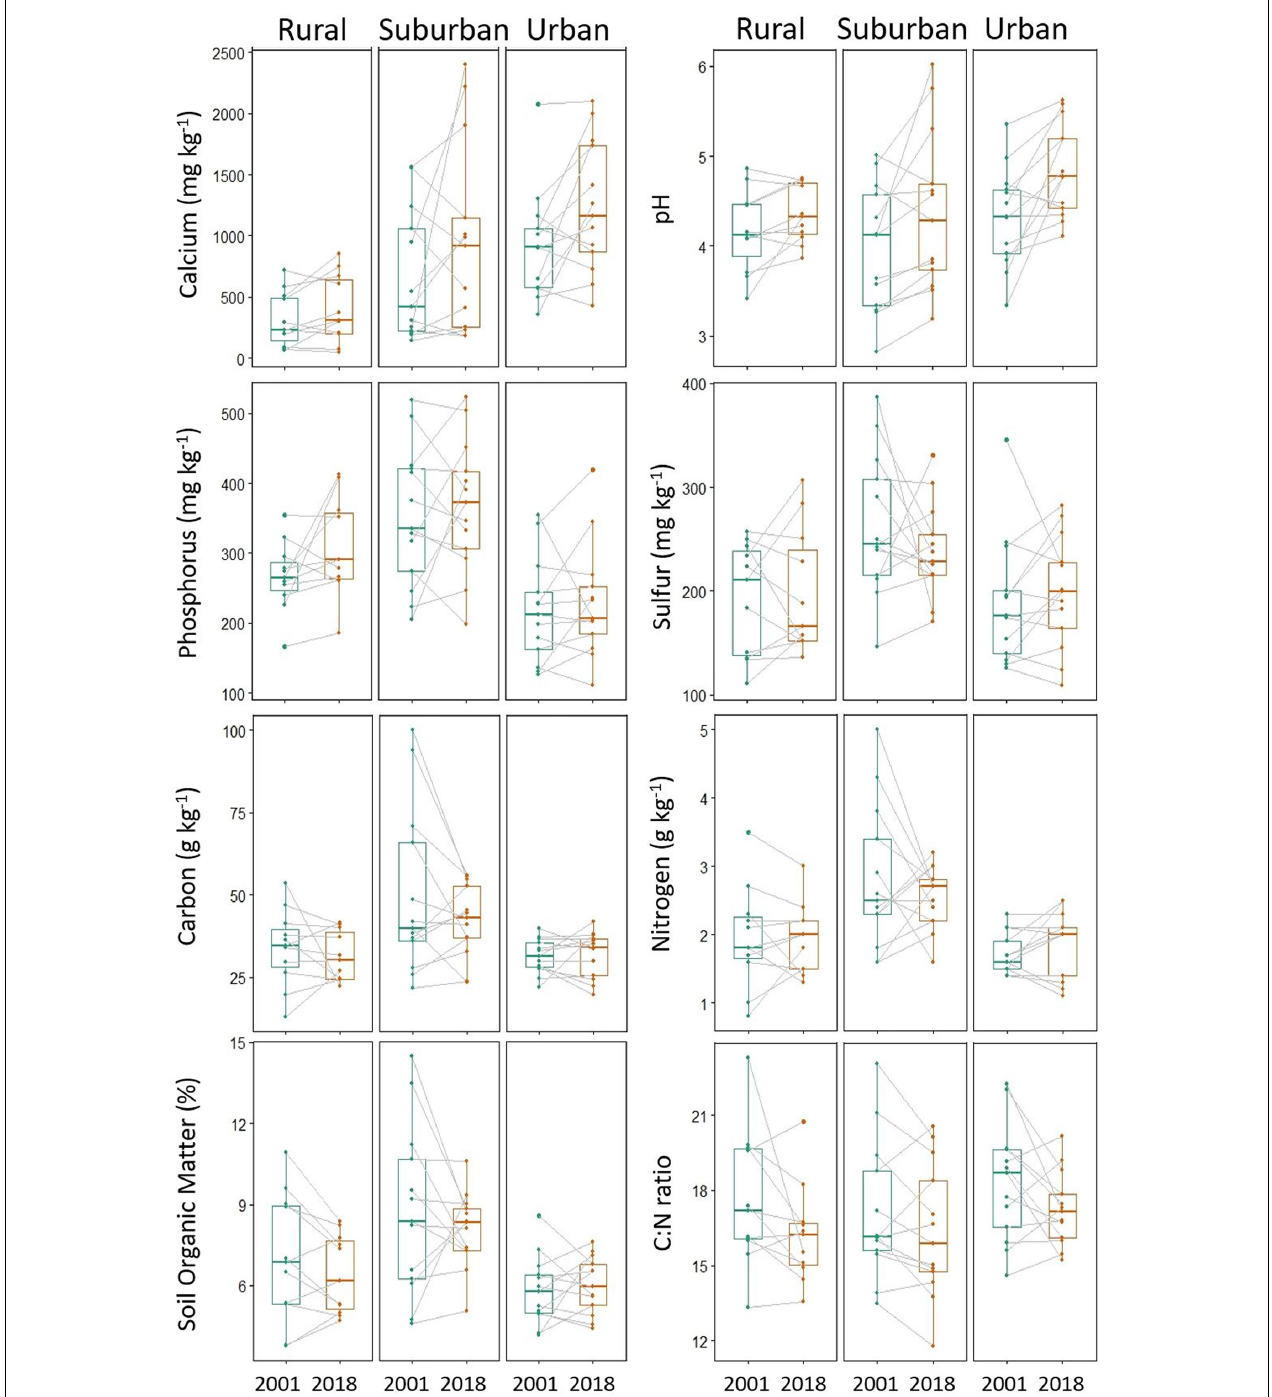
FIGURE 3 | Change in eight soil properties between 2001 and 2018 along the urban-rural gradient. Box plots show changes at the plot level ( n = 36) separately for rural (R), suburban (S), and urban (U).